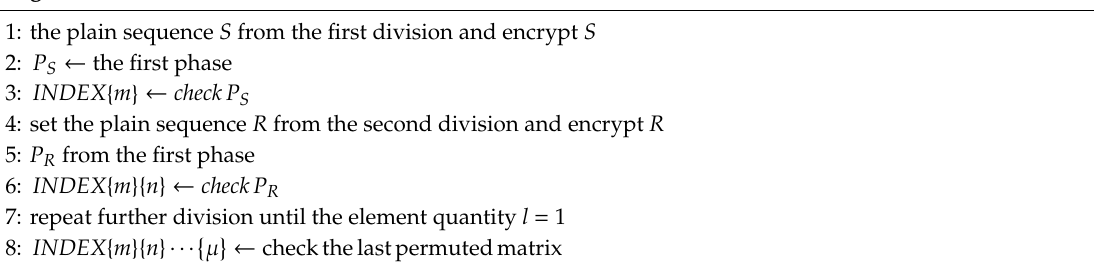
Algorithm 2 Permutation Attack